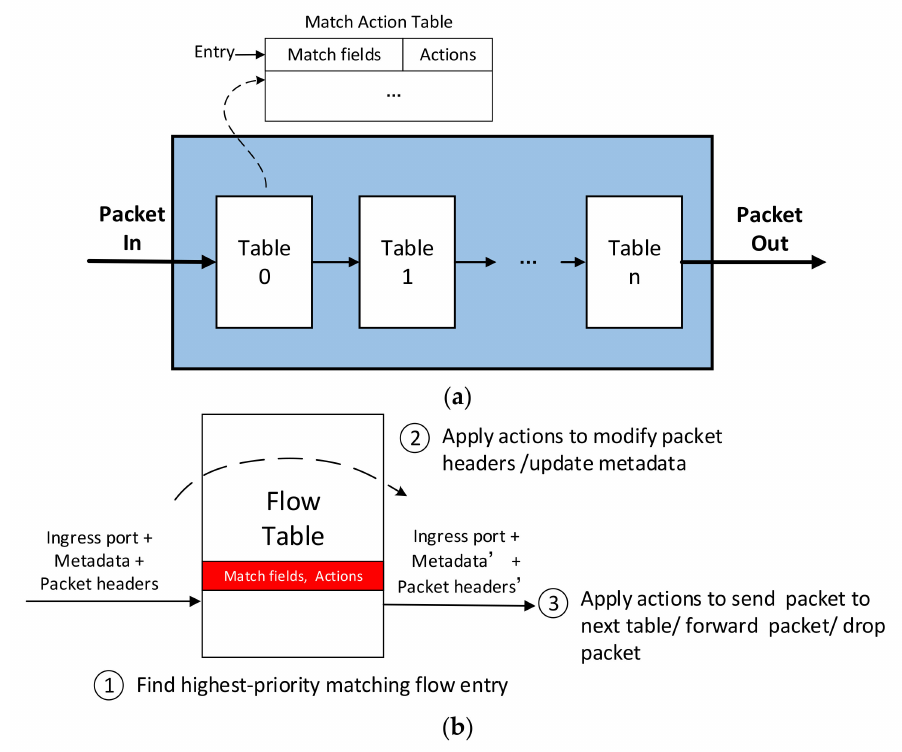
Figure 1. Pipeline process packets. ( a ) The packet matches the match–action table in the Pipeline. ( b ) Match–action table processing